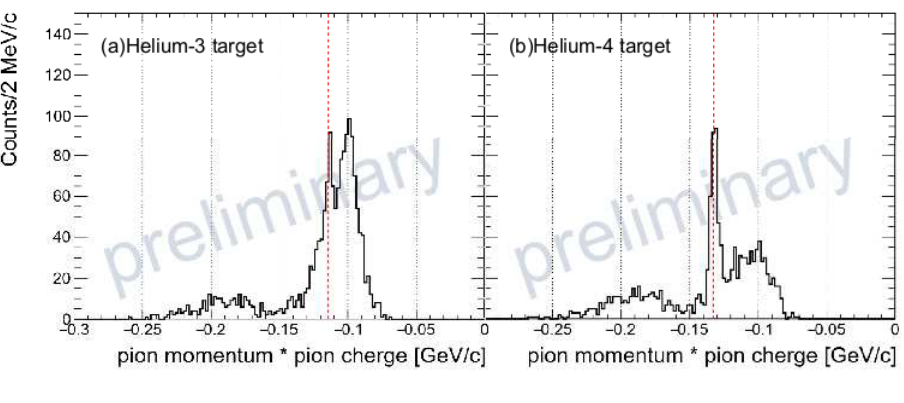
Figure 1. (a)The mesonic weak Mono-energic